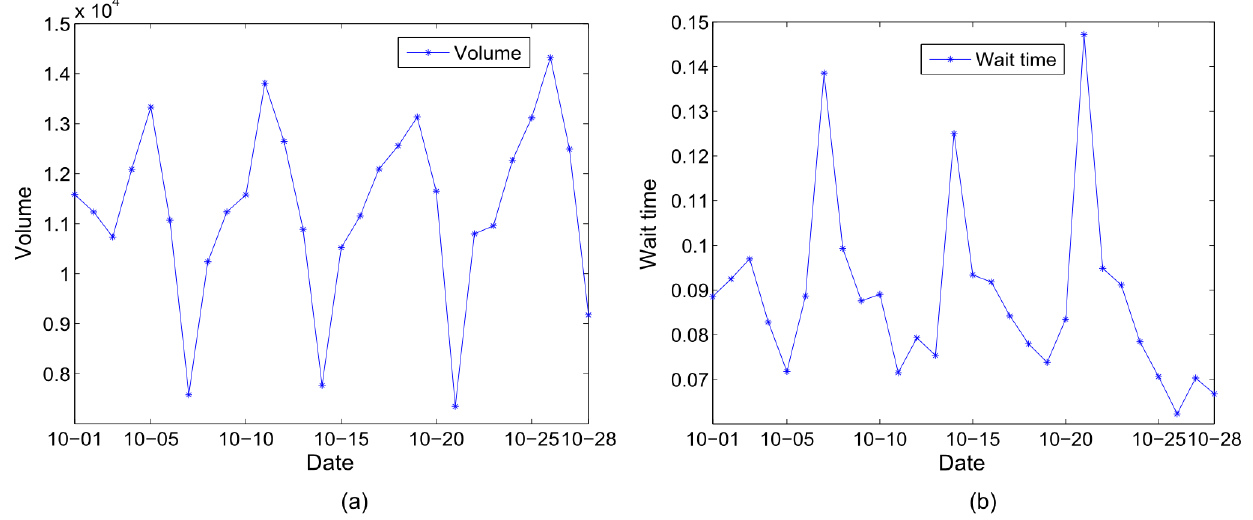
Figure 5. Plot of human activities changing on a daily basis (Note: These uncover the periodic regularity of activities on a daily basis. To be specific: ( a ) reflects this regularity from the SPs volume; ( b ) reveals this pattern from the SPs wait time, which depicts the same regularity from the opposite